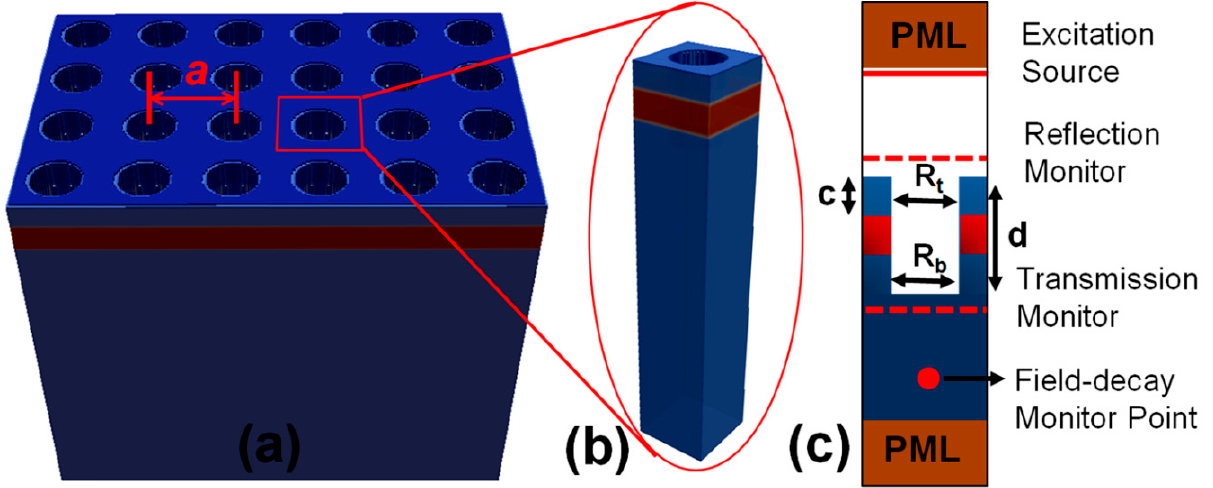
Figure 3. Simulation model of the fabricated dielectric PhC device. ( a ) A 3D model of the device with a waveguide layer on top of the substrate and covered by a cladding layer. ( b ) 3D view of the unit cell model used in the simulation. ( c ) Cross-sectional view of the unit cell model showing PhC structure, source, field monitoring points and boundary conditions.